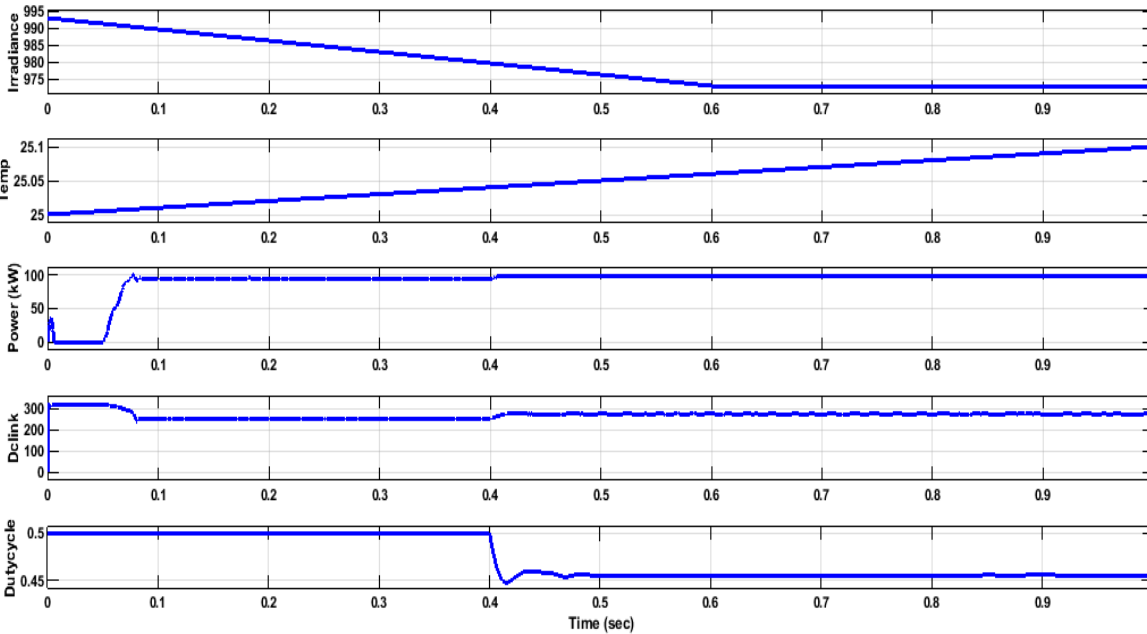
Figure 8. Performance analysis using the ANN method.